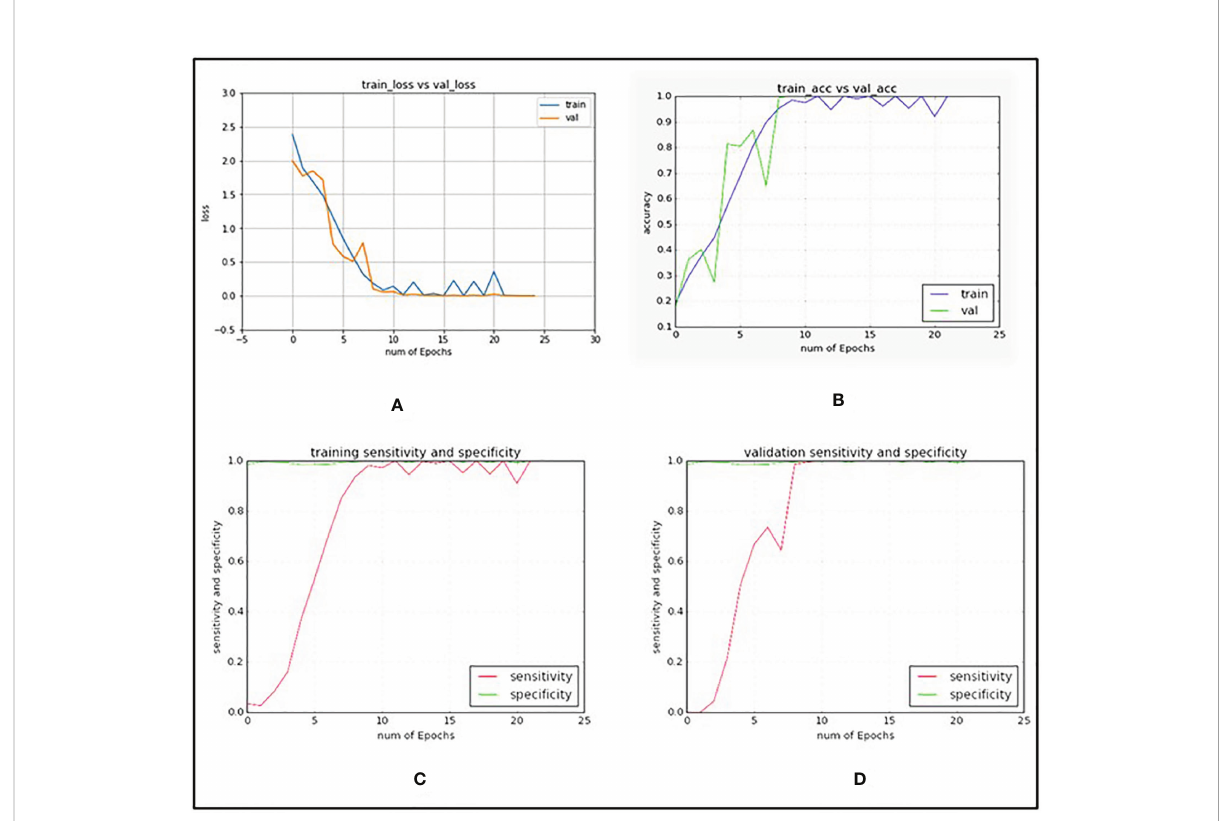
FIGURE 6 Graphs generated when custom VGG16 network was trained and validated with PCA-5 most contributing bands and with images containing 5 fruit instances (TC3). (A) CNN training and validation loss graph. (B) CNN training and validation accuracy graph. (C) CNN sensitivity and